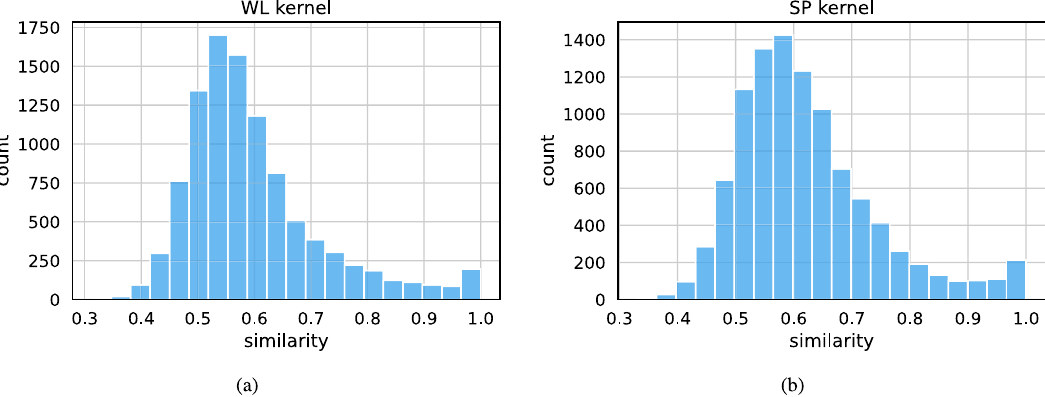
Fig. 4 Histograms of similarities between input and generated trajectories. The model was used to generate 10,000 synthetic trajectories, and for each synthetic trajectory, the most similar input trajectory was found. a Histograms of similarities between input and generated trajectories using the Weisfeiler – Lehman subtree (WL) kernel. b Histograms of similarities between input and generated trajectories using the shortest path (SP)